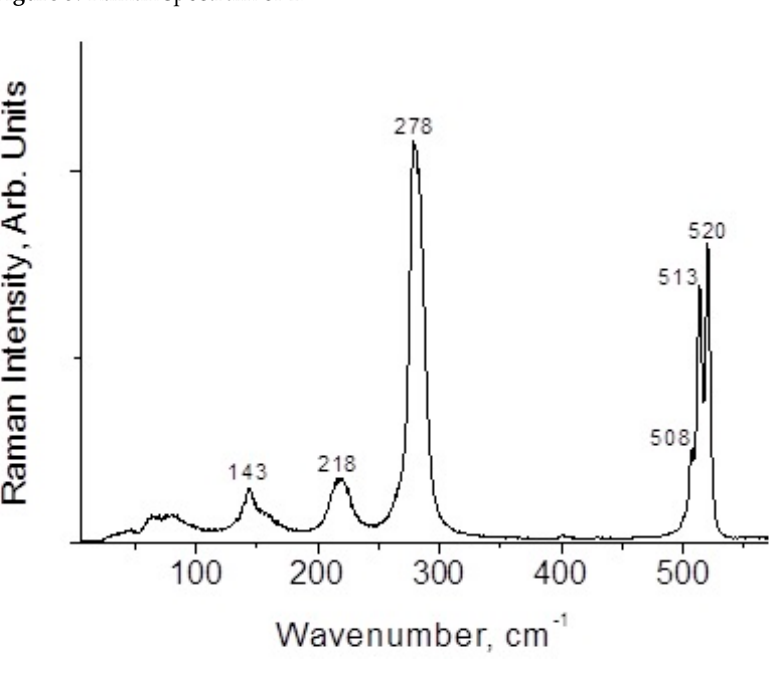
Figure 6. Raman spectrum of 2.